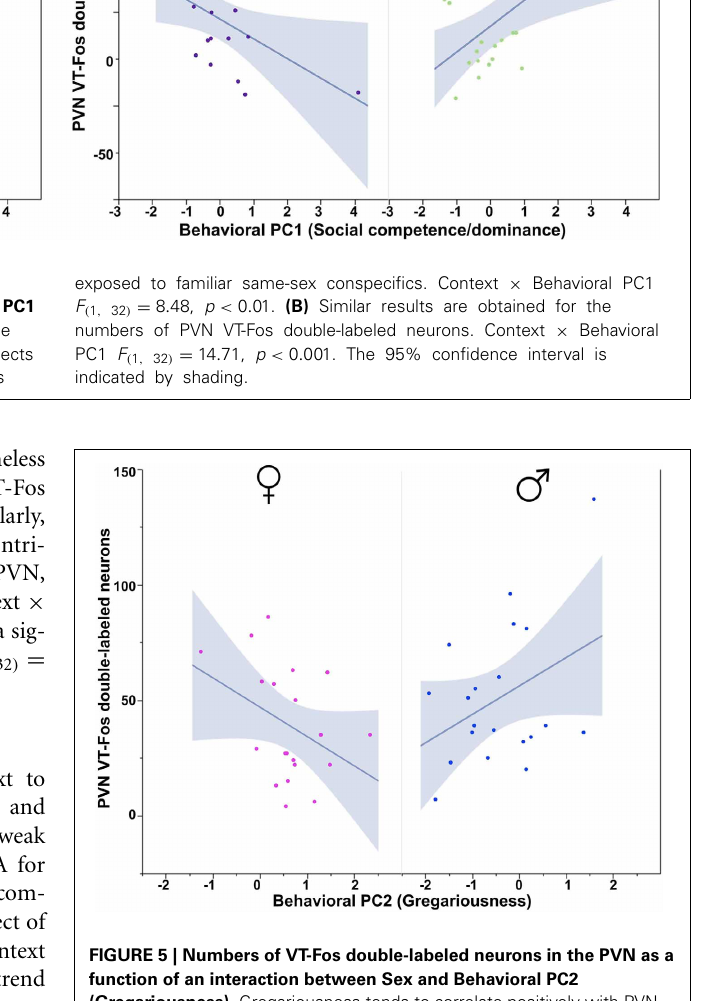
FIGURE 5 | Numbers of VT-Fos double-labeled neurons in the PVN as a function of an interaction between Sex and Behavioral PC2 (Gregariousness). Gregariousness tends to correlate positively with PVN VT neurons expressing Fos in males, but negatively in females. Sex × Behavioral PC2 F ( 1 , 32 ) = 5 . 28, p = 0 . 03. The 95% confidence interval is indicated by